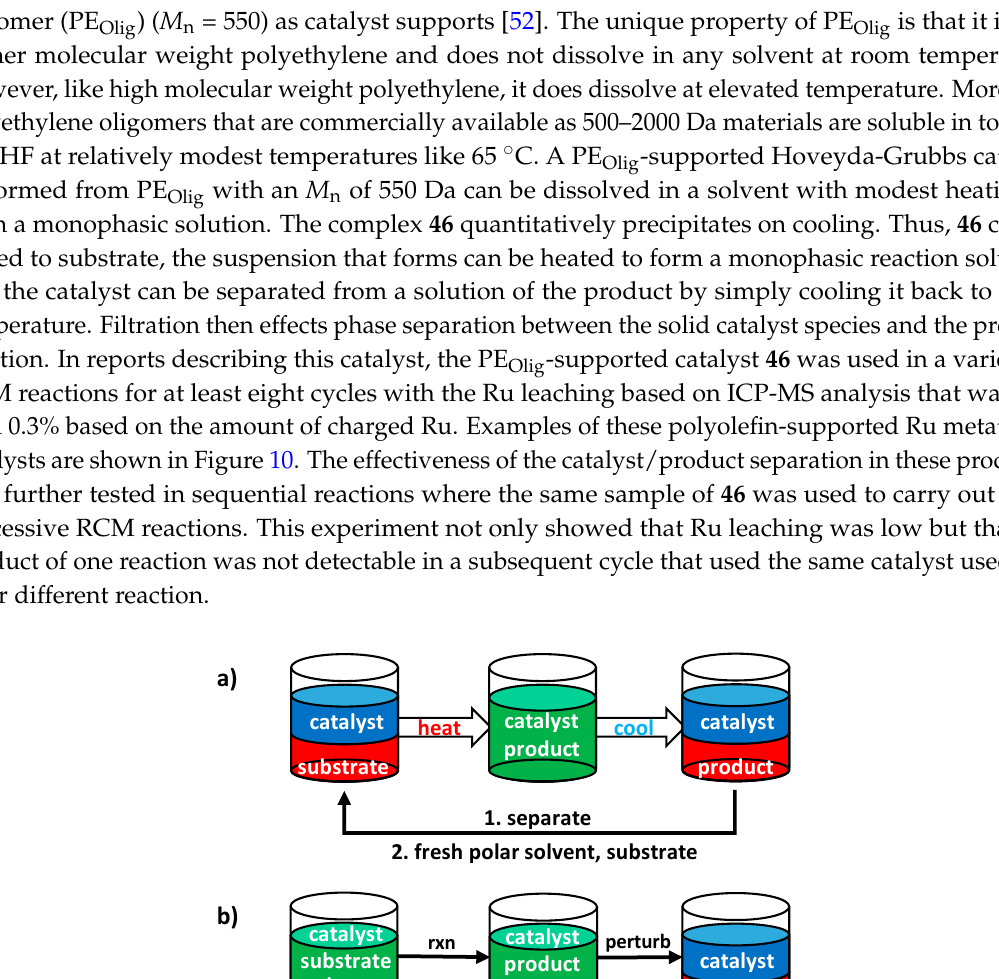
Figure 10. Polyolefin-supported Hoveyda-Grubbs catalysts 44 – 46 .